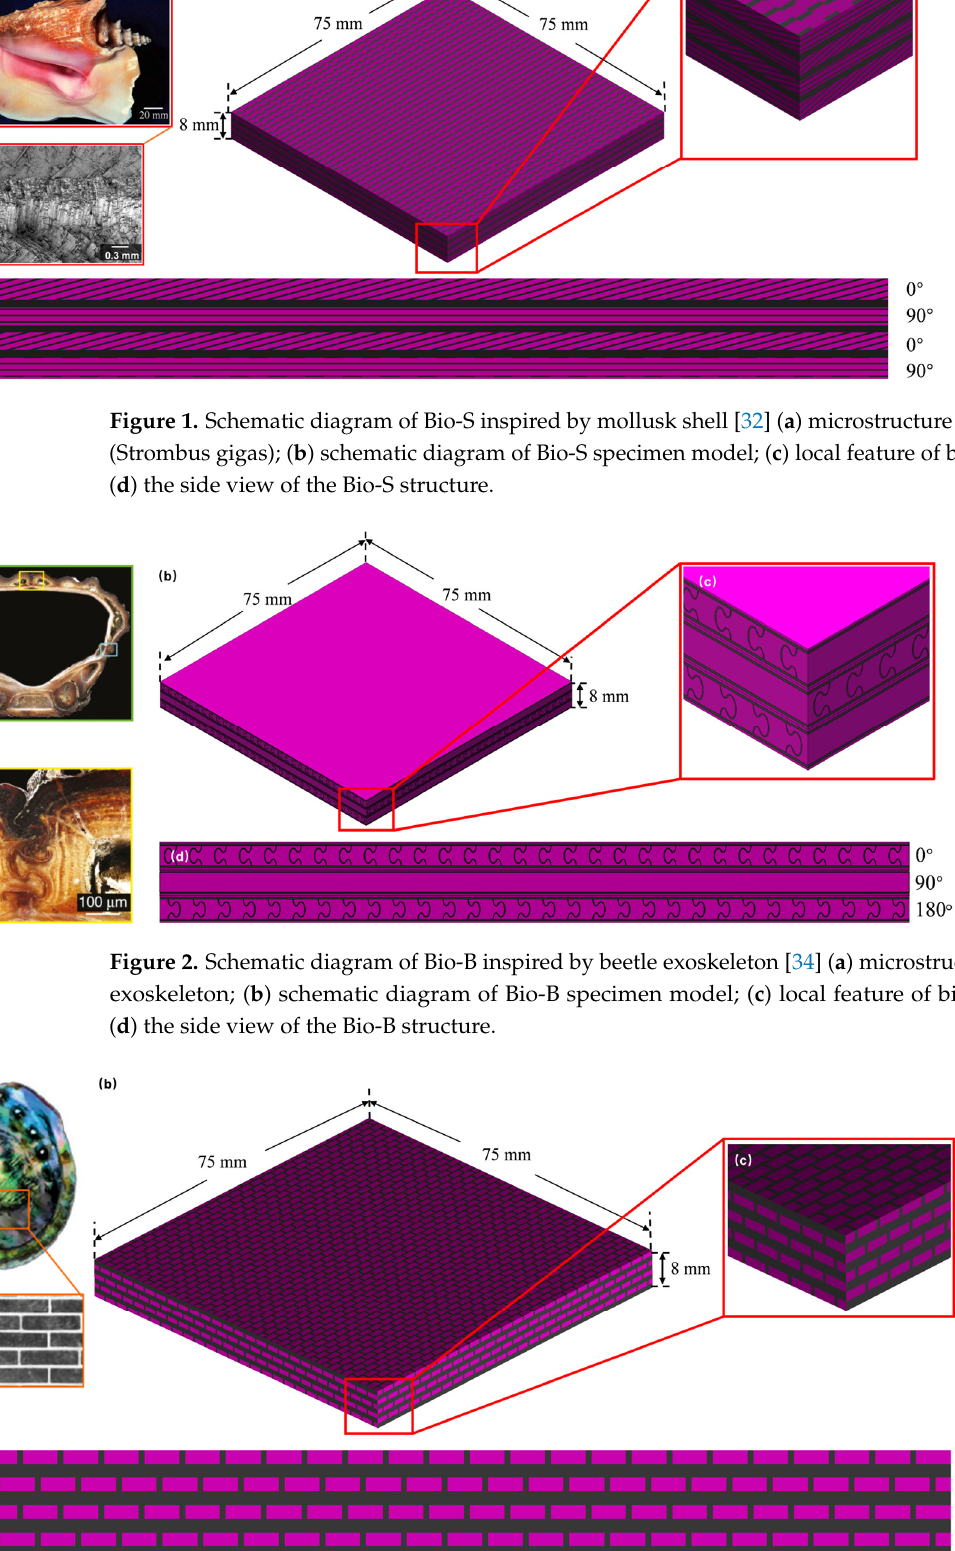
Figure 3. Schematic diagram of Bio-N inspired by nacre [31] ( a ) microstructure of nacre; ( b ) schematic diagram of Bio-N specimen model; ( c ) local feature of bio-N structure; ( d ) the side view of the Bio-N structure.